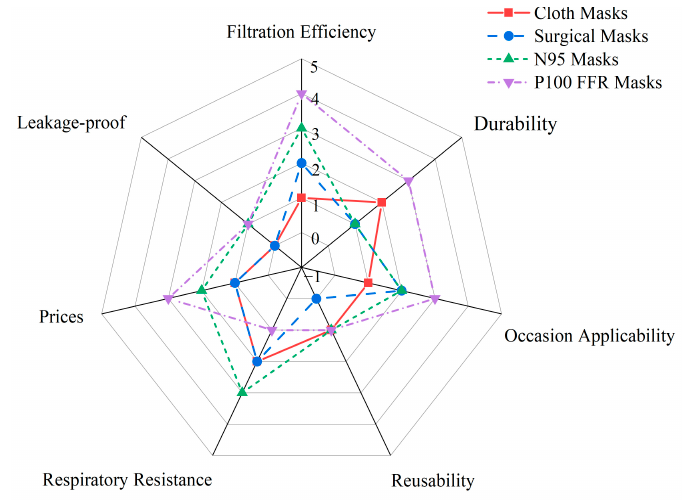
Figure 5. The filtration performance evaluation of masks.